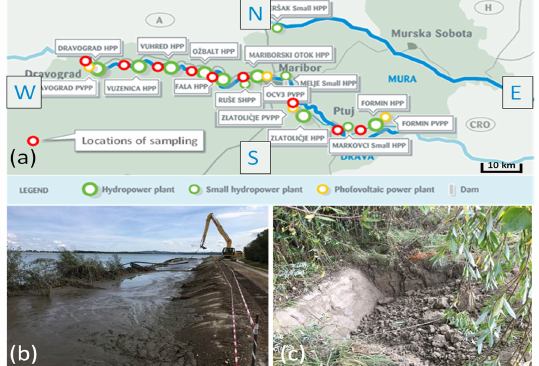
Figure 1. Schematic presentation of the locations ( a ) at which the sediments were sampled with selected sediments on the shore of lake Ptuj—“Lake Ptuj fresh” ( b ); and “Lake Ptuj 9”( c ). Table 1. Water 1 and LOI at 950 °C 2 levels in the tested Drava River sediments. Sample